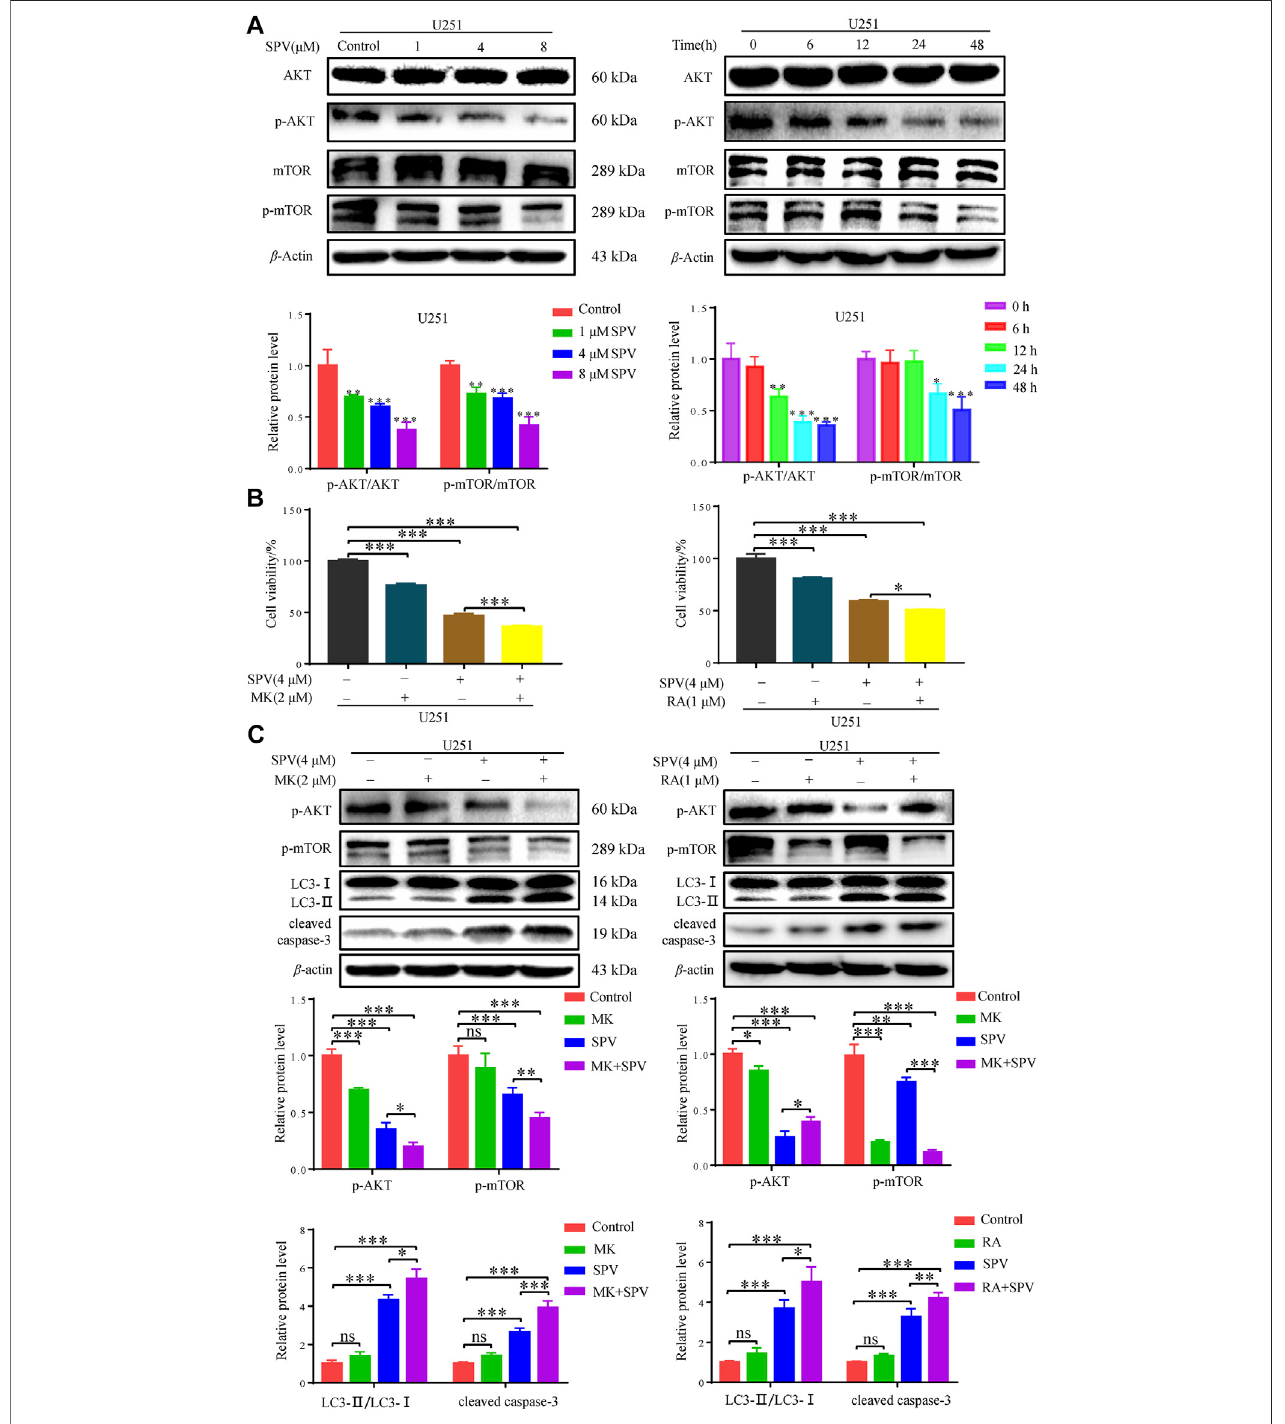
Figure 7 | Sempervirine induced apoptosis and autophagy by inhibiting the AKT/mTOR pathway. (A) U251 cells were treated with various concentrations (0, 1, 4 and 8 μ M) of sempervirine or incubated with sempervirine (4 μ M) for different durations for 48 h. Western blotting for the level of p-AKT, AKT, p-mTOR, mTOR. (B) Cell viability was determined. MK (2 μ M) or RA (1 μ M) was added to cells 2 h before sempervirine treatment. Then, cells treated with sempervirine for 48 h. Cell viability was determined by MTT. (C) MK (2 μ M) or RA (1 μ M) was added to cells 2 h before sempervirine treatment. After 48 h, the protein level of p-AKT, p-mTOR, LC3 and cleaved caspase-3 were determined by Western blotting. Data are presented as the Mean ± SD ( n (cid:2) 3). * p < 0.05, ** p < 0.01 and *** p < 0.001 compared with the control group.